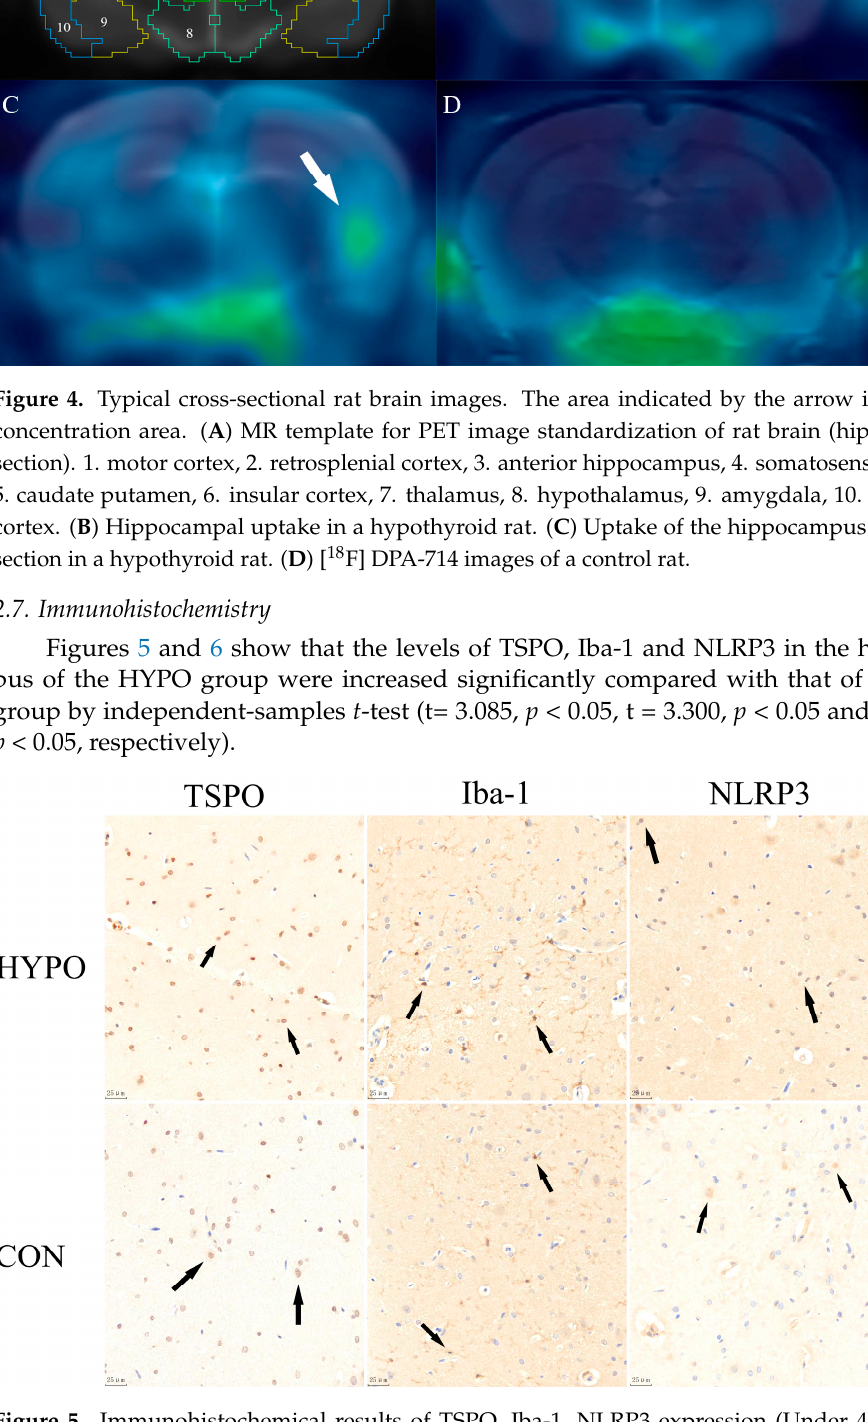
Figure 5. Immunohistochemical results of TSPO, Iba-1, NLRP3 expression (Under 40× optical microscope). Brown cells are positive (as shown by the black arrow) and blue cells are negative.